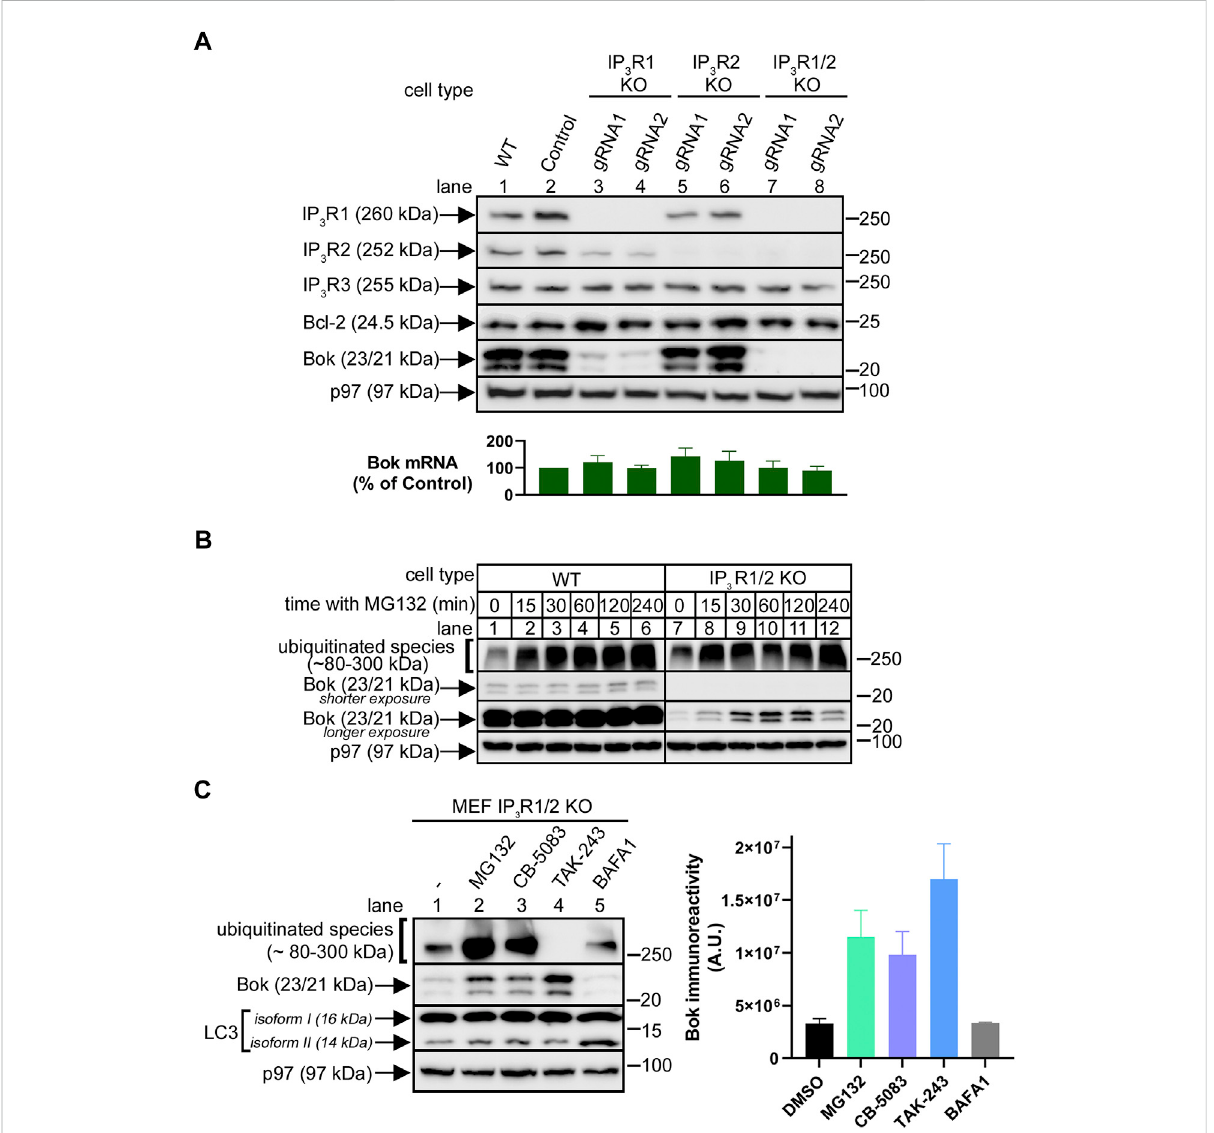
FIGURE 3 Endogenous Bok expression in MEFs is dramatically reduced by IP 3 R1 and IP 3 R2 deletion. (A) , Immunoreactivity of Bok and other pertinent proteins in lysates from WT, control and IP 3 R1, IP 3 R2, or IP 3 R1/2 KO MEFs, with p97 serving as a loading control. For both IP 3 R1 and IP 3 R2, two different gRNAs were used (lanes 3 – 8). The histogram shows Bok mRNA levels in control and IP 3 R KO MEFs, mean ± SEM, n = 4. (B) , ImmunoreactivityofBokandubiquitinated speciesinlysatesfromWTandIP 3 R1/2KOcellsincubatedwith10 µMMG132 forvarious times,with p97 serving as a loading control. (C) , Immunoreactivity of Bok and other pertinent proteins in lysates from IP 3 R1/2 KO cells incubated with 10 µM MG132, CB-5083, TAK-243, and 100 nM ba fi lomycin A1 (BAFA1) for 2 h, with p97 serving as a loading control. Changes in the levels of ubiquitinated species and LC3 isoform II serve as positive controls for the various drugs. The histogram shows quantitated Bok immunoreactivity, mean ± SEM, n =